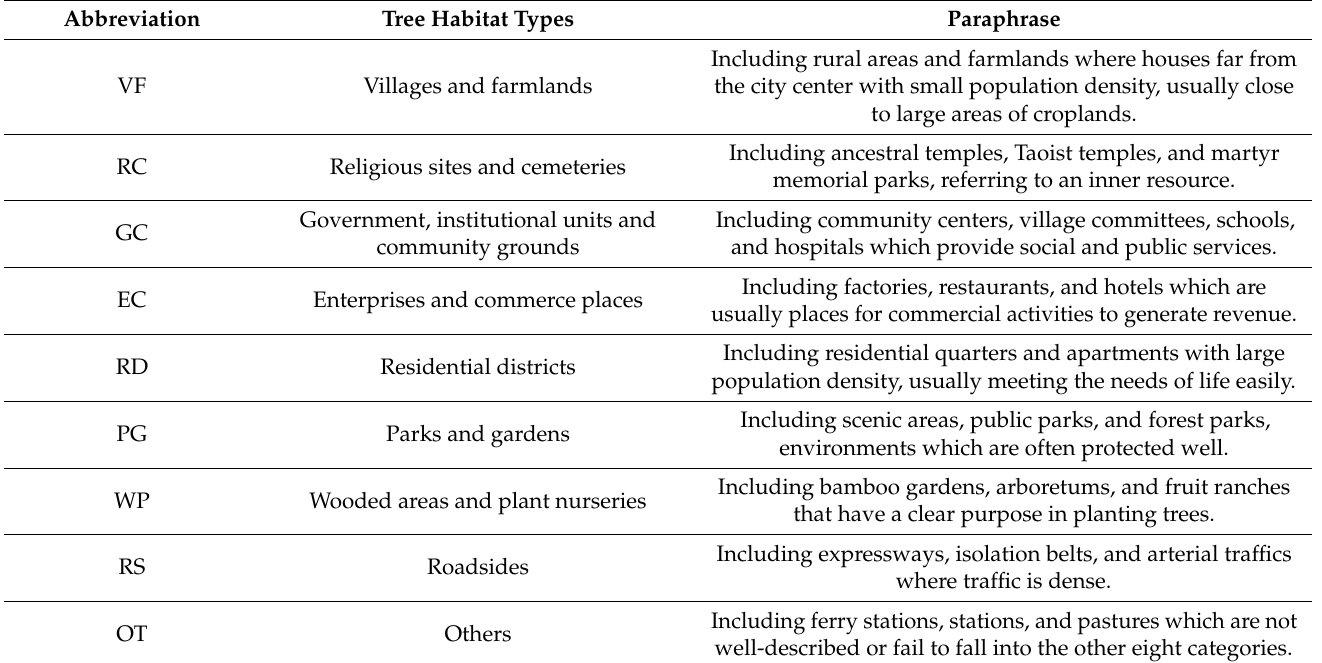
Table 3. Nine tree habitat types which accommodate heritage trees were identified in Jiangsu Province, eastern